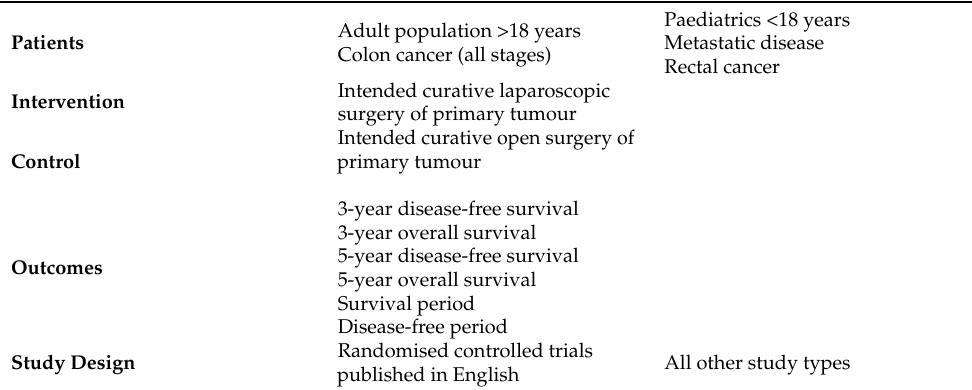
Table 1. Inclusion and exclusion criteria used in the literature